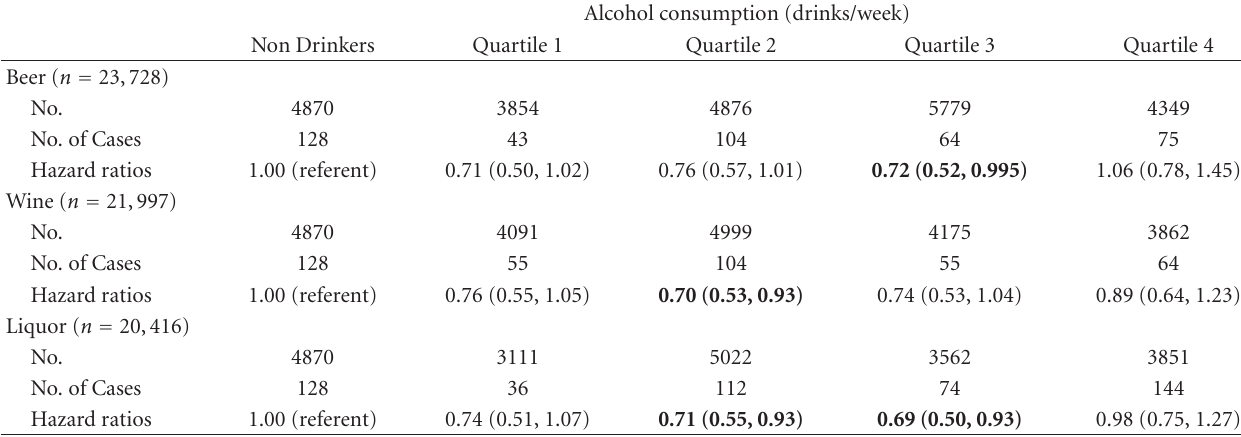
Table 7: Hazard ratios of CVD mortality stratified by types of alcohol beverage a , Aerobics Center for Longitudinal Study (ACLS), 1974–2002. Alcohol consumption